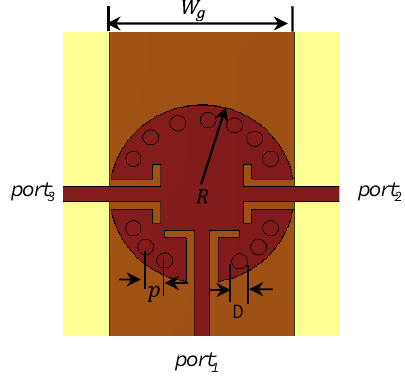
Figure 1. Power splitter configuration.